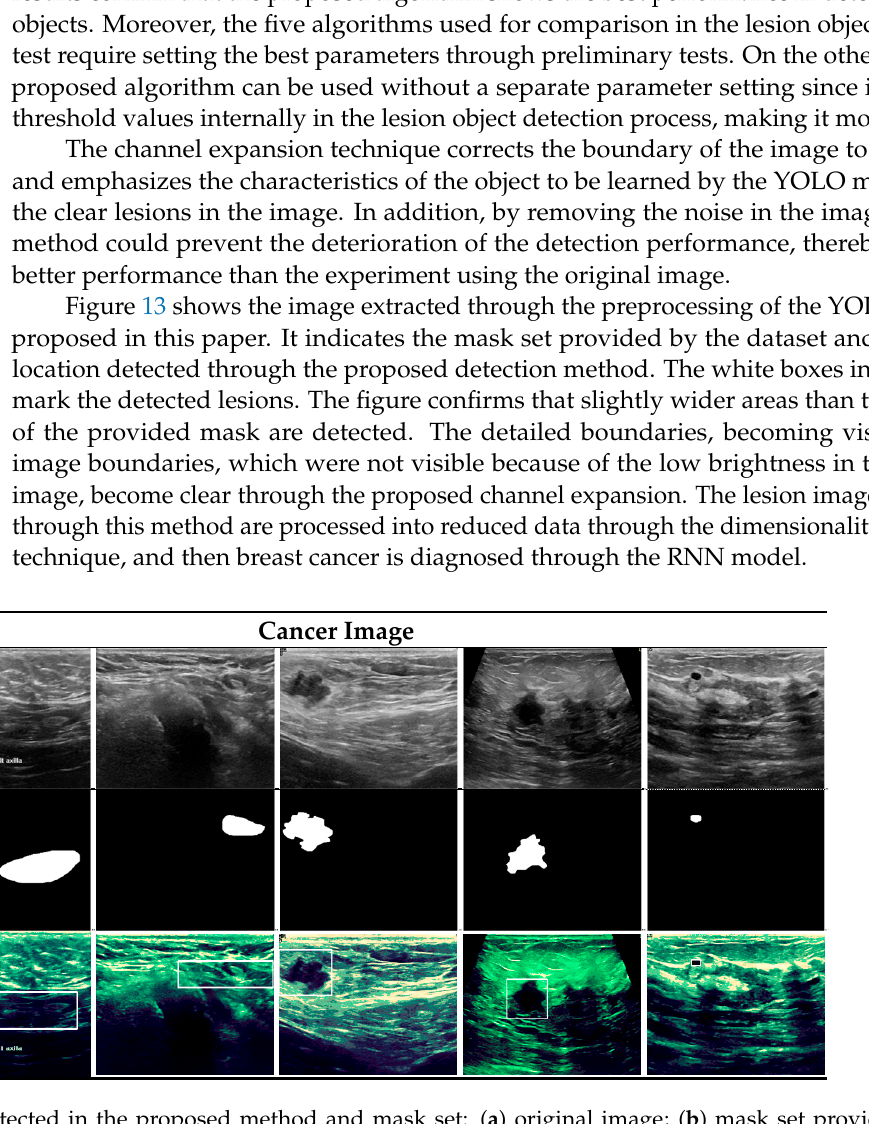
Figure 12. The accuracy measurement result of the lesion object detection algorithm.